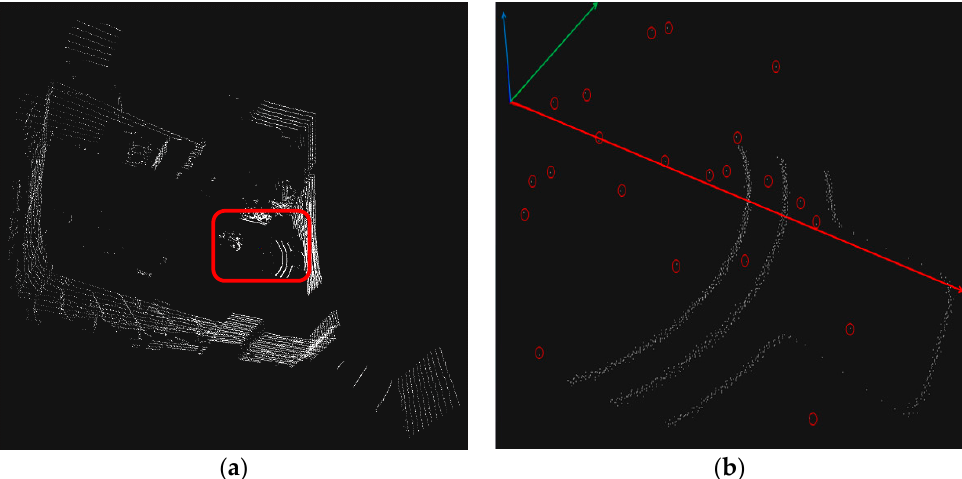
Figure 3. Before and after PassThrough filter comparison. ( a ) PassThrough filter the front point cloud data; ( b ) rendering after PassThrough filter.